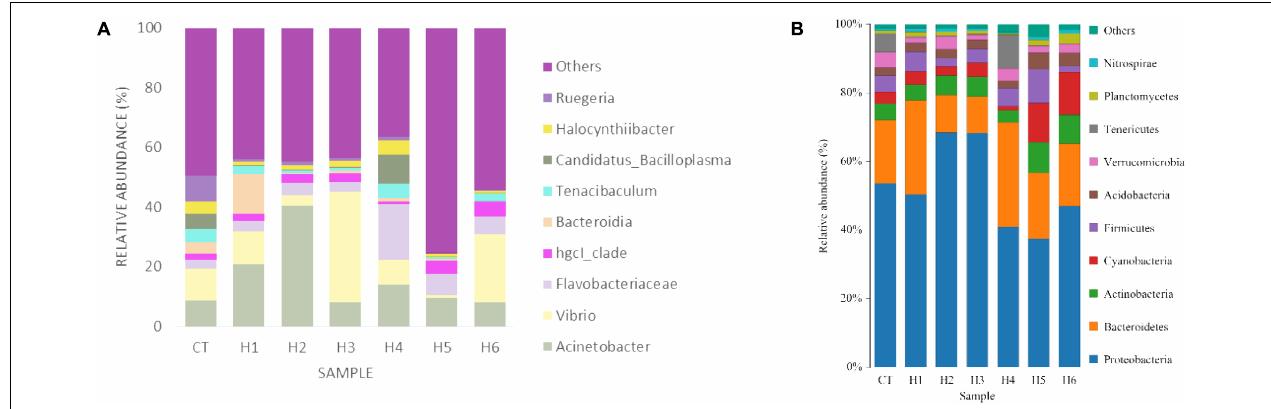
FIGURE 3 | Effect of HFP on genus (A) and phylum (B) diversity in the intestine of juvenile pearl gentian hybrid grouper.